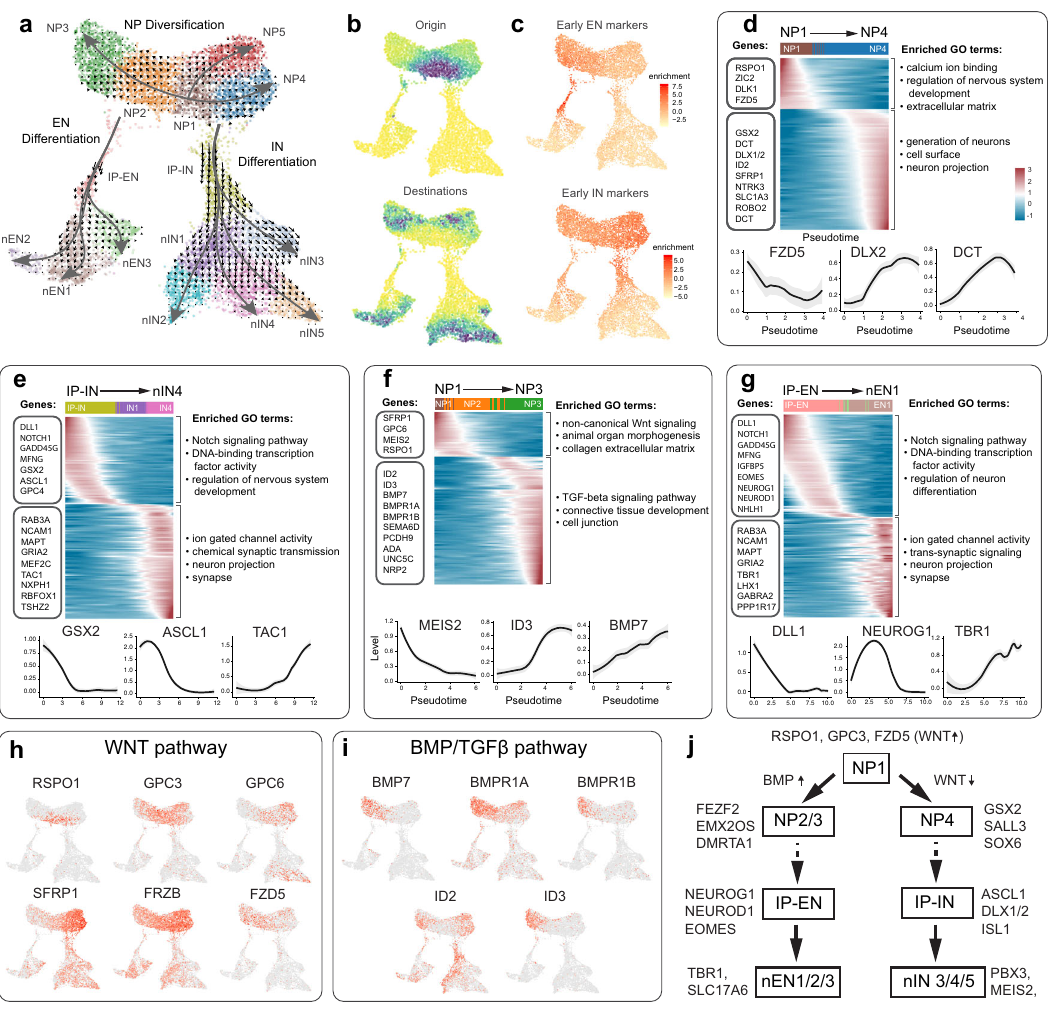
Fig. 3 | Transcriptional programs and signaling pathways associated with speci fi cation of excitatory and inhibitory neural lineages in 1-month-old SNR- derived organoids. a RNA velocity vector fi elds and developmental trajectories. Small arrows indicate extrapolated future states of cells. Large arrows indicate branchinglineagetrajectoriesconstructedusingSlingshotandinitializedusingthe origin and end states of the Markov simulation. b The origin and end states of the differentiationlandscapedeterminedusingMarkovrandomwalksimulationonthe velocity fi eld. The density of cells at the end of the simulation is shown using the color scale ranging from yellow (low) to blue (high). c Enrichment of early differ- entiationgenesfromtheENandINdifferentiationtrajectories. d – g Smoothedgene